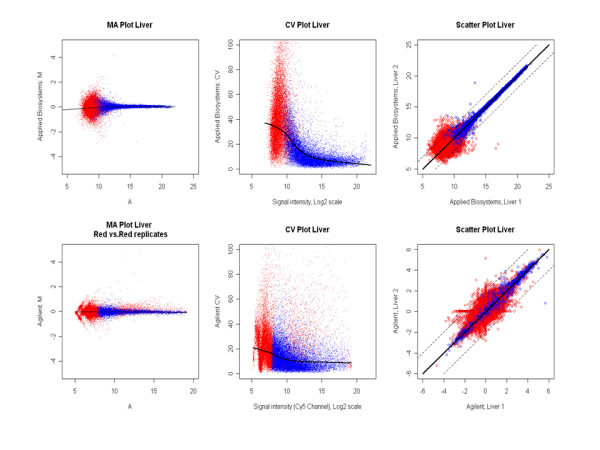
Intra-platform reproducibility of the two microarray platforms. Data on liver sample are shown as a representative example. All 21,171 common genes are represented in these plots. Blue points: concordantly detectable on both replicates; Red points: not detectable in either replicate. (A). M-A plots of two technical replicates analyzed by the two microarray platforms. x-axis: A = 0.5*log2 (Signal_rep1*Signal_rep2); y-axis: M = log2 (Signal_rep1/Signal_rep2). (B). Coefficients of variation (CV) for each microarray platform as a function of gene expression level across four technical replicates. For Agilent arrays, only signals of Cy5 channel were used for illustration in these plots. The black line represents a loess smoothing fitting curve to the 84,684 data points in each platform. (C). Scatter plots of the expression levels measured by each microarray platform for the two technical replicates: For Applied Biosystems arrays, expression levels are represented by signal intensity directly; for Agilent arrays, the expression levels are represented by relative ratio vs. common reference sample (UHR). The black dashed lines indicate the ± 2-fold changes.